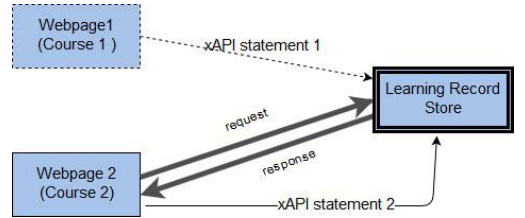
Figure 3. The architecture of our learning content. A dashed box suggests that the course is not required and dashed lines that the relevant statement may not be sent to the LRS. Thick arrows show the communication between the course and the LRS regarding the existence of xAPI